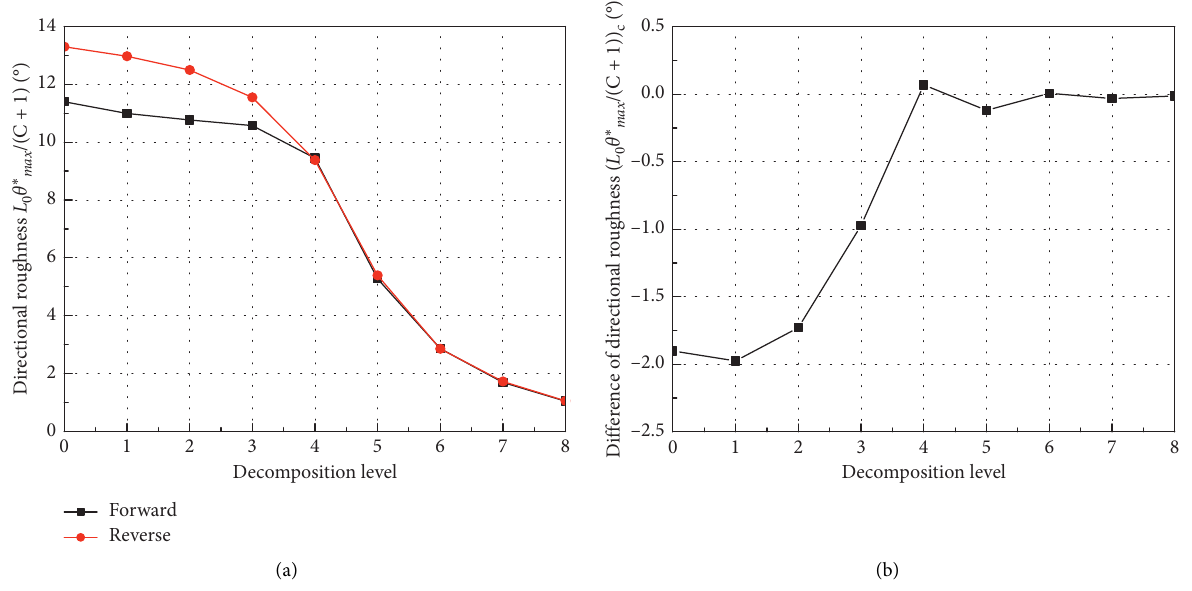
Figure 11: The relationship between the roughness in the forward and reverse directions (a) L ( L θ ∗ / ( C + 1 )) C with the decomposition level. 0 max